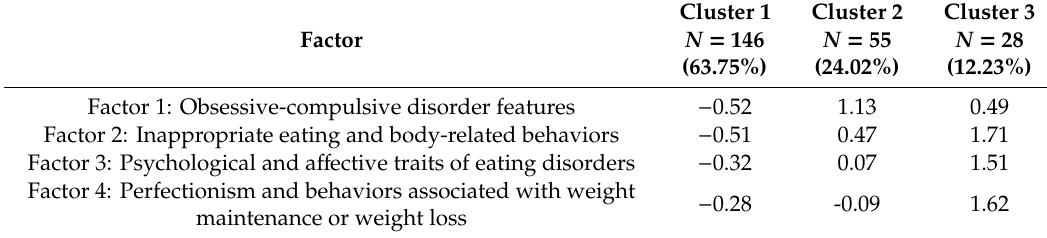
Table 3. Results of cluster analysis.